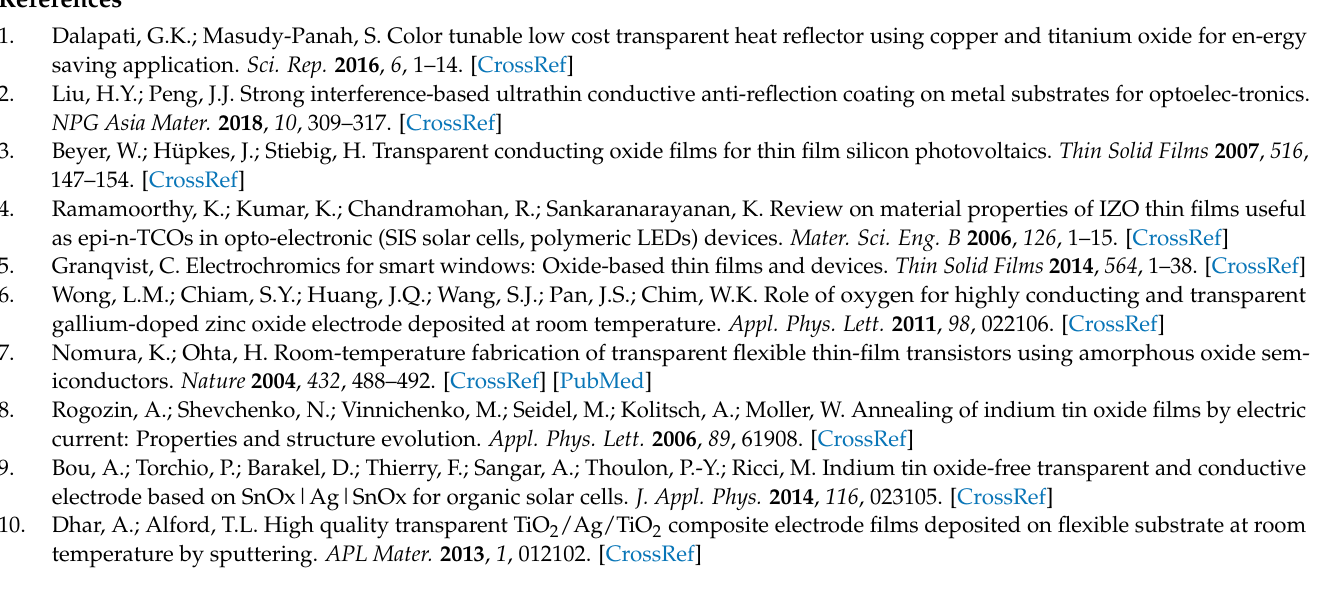
multilayers can be used as reliable transparent material for electrothermal